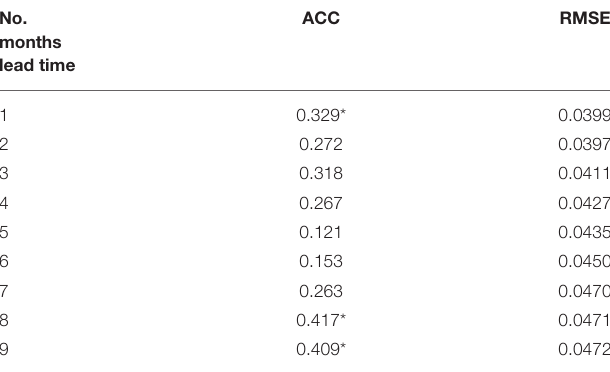
TABLE 2 | Anomaly Correlation Coefficient (ACC) and RMSE between the chlorophyll concentration in the Equatorial Pacific from the forecast at 1- to 9-month lead time and the corresponding monthly chlorophyll concentration from S-NPP